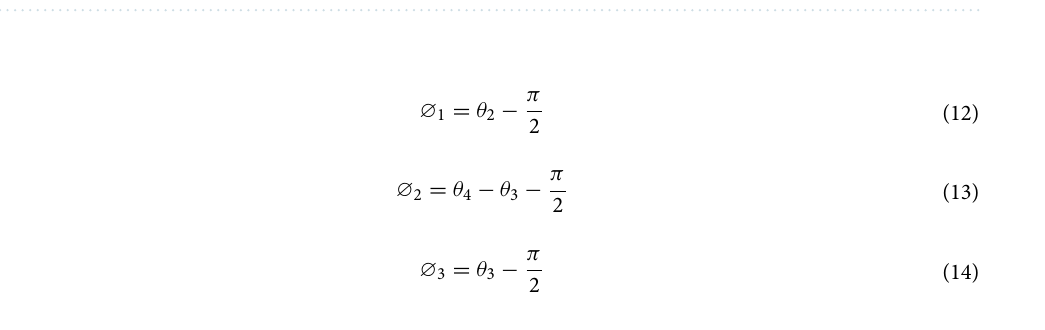
Table 2. The coupling ratio of the directional coupler DC 1 , DC 2 and DC 3 and the phase delay of the phase modulators PM 1 , PM 2 and PM 3 . Significant values are in